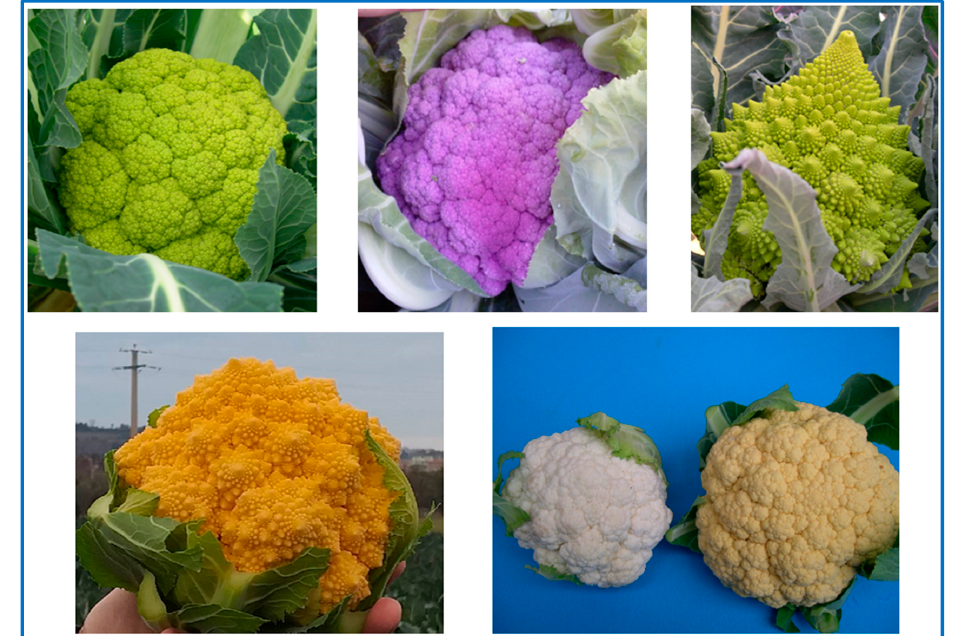
Figure 3. Examples of cauliflower types grouped by colour. From left to right and from top to bottom: green cauliflower, violet/purple cauliflower, green Romanesco cauliflower, orange Romanesco cauliflower, white and light yellow/pale green cauliflower.